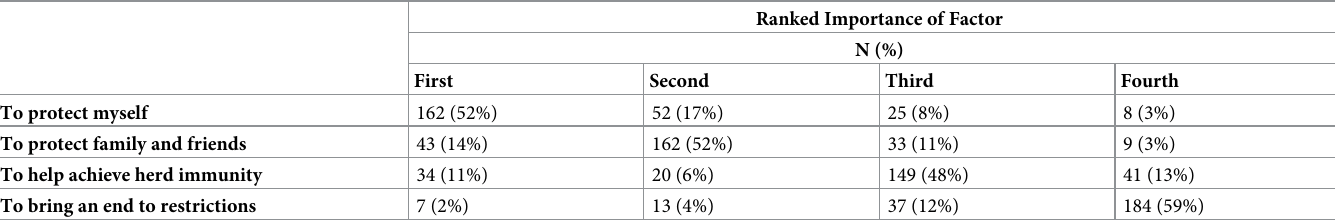
Table 3. Rank-ordering of factors affecting COVID-19 vaccine